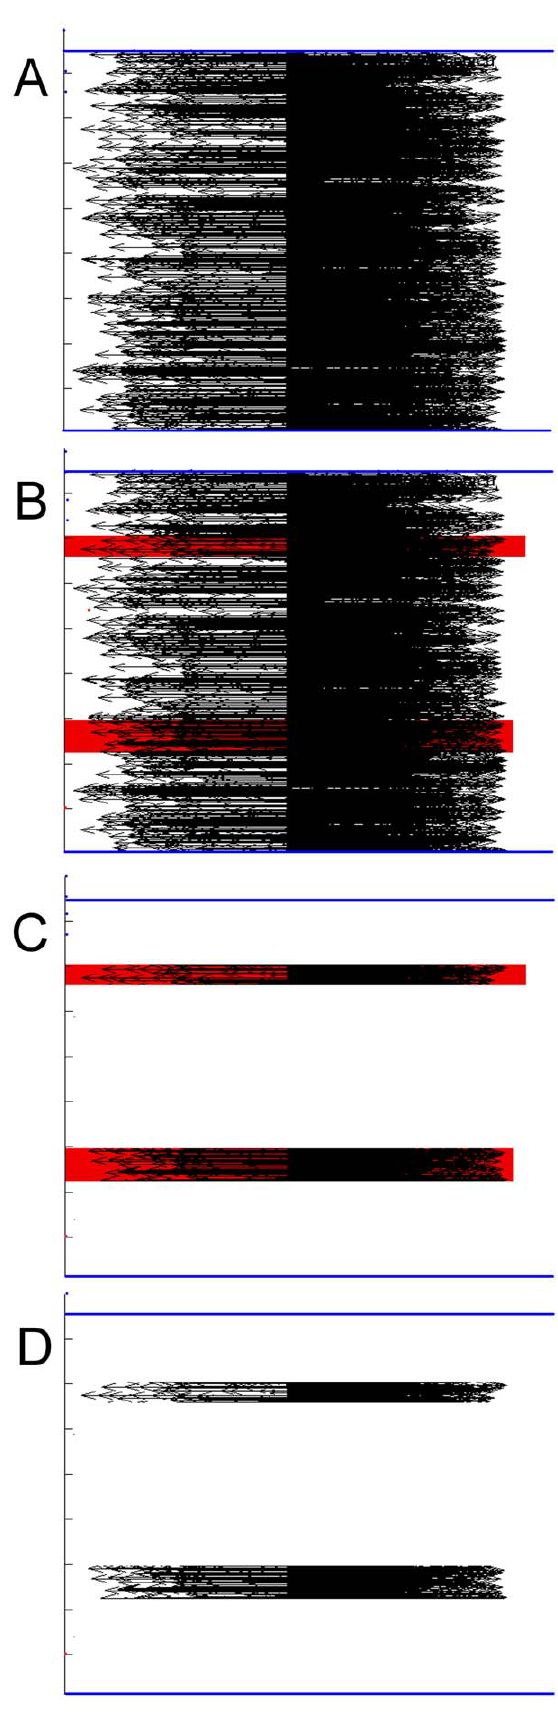
Figure 10. Building a fragment library. Panels A, B, C, D describe the process of extracting curve fragments. Autoregression allows re-use of the curve fragments for comparisons between curves. Starting with the W-curve for a genome or gene (A), regions corresponding to the sequences of interest are found (B) and the remainder of the curve dropped (C), leaving a set of smaller curves (D). The set of curve fragments can be used to search for a list of regions in or score only part of a gene. For example, scoring only the conserved regions of gp120 may prove more effective for generating phenograms than using the entire gp120 sequence or env